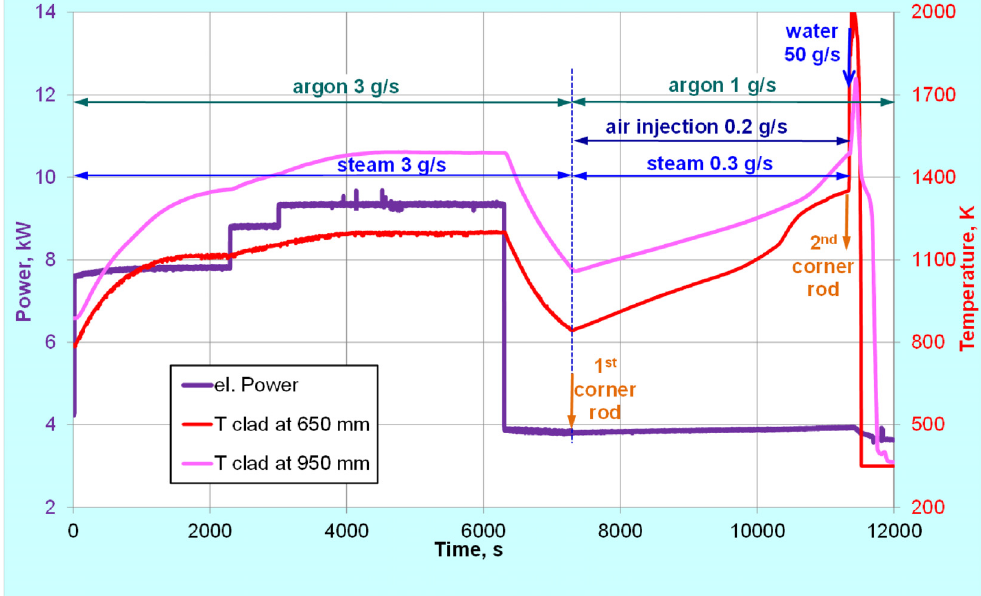
Fig. 4. Experimental protocol of the QUENCH test on air ingress planned in SAFEST ( © KIT,